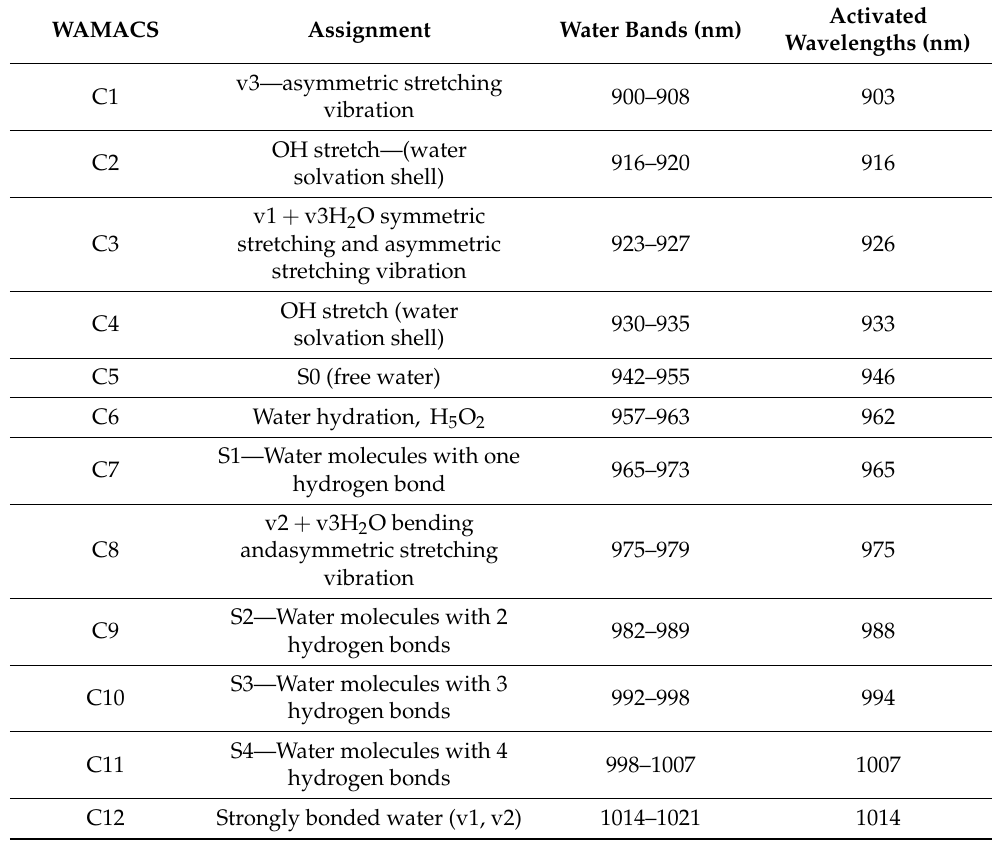
Table 2. Assignment of water absorbance bands for second overtone of water using the anharmonic oscillator model